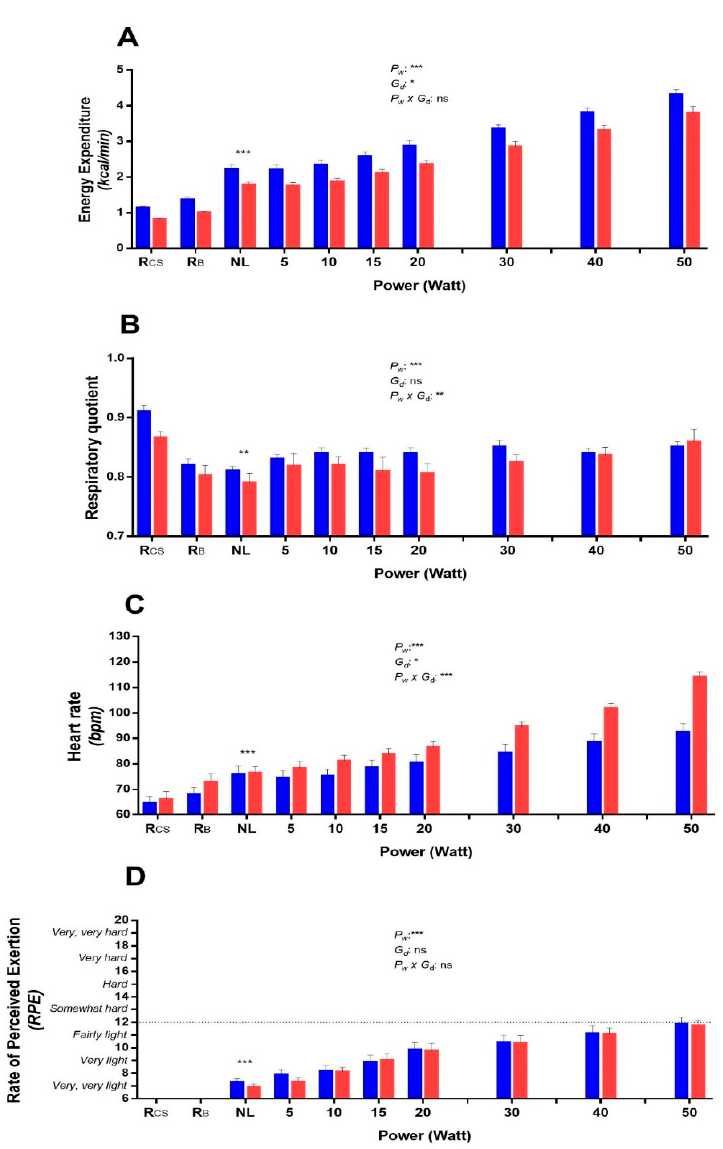
Figure 4. In response to no-load cycling, EE increased by about 2 folds ( p < 0.001), while RQ dropped ( p < 0.01) in comparison to values during resting in the car seat (panels A and B, respectively). A linear increase in EE between 2–4 times above resting levels was observed across 5 to 50 W ( p < 0.001), and although RQ increased significantly across this range ( p < 0.001), this was very modest, and these RQ values across very low- to low-power cycling remained below that observed while at rest. Both HR and RPE increased linearly or curvi-linearly across 5 to 50 W ( p < 0.001), but the mean RPE did not exceed values corresponding to the exercise being perceived as ‘light’ (panels C and D, respectively).